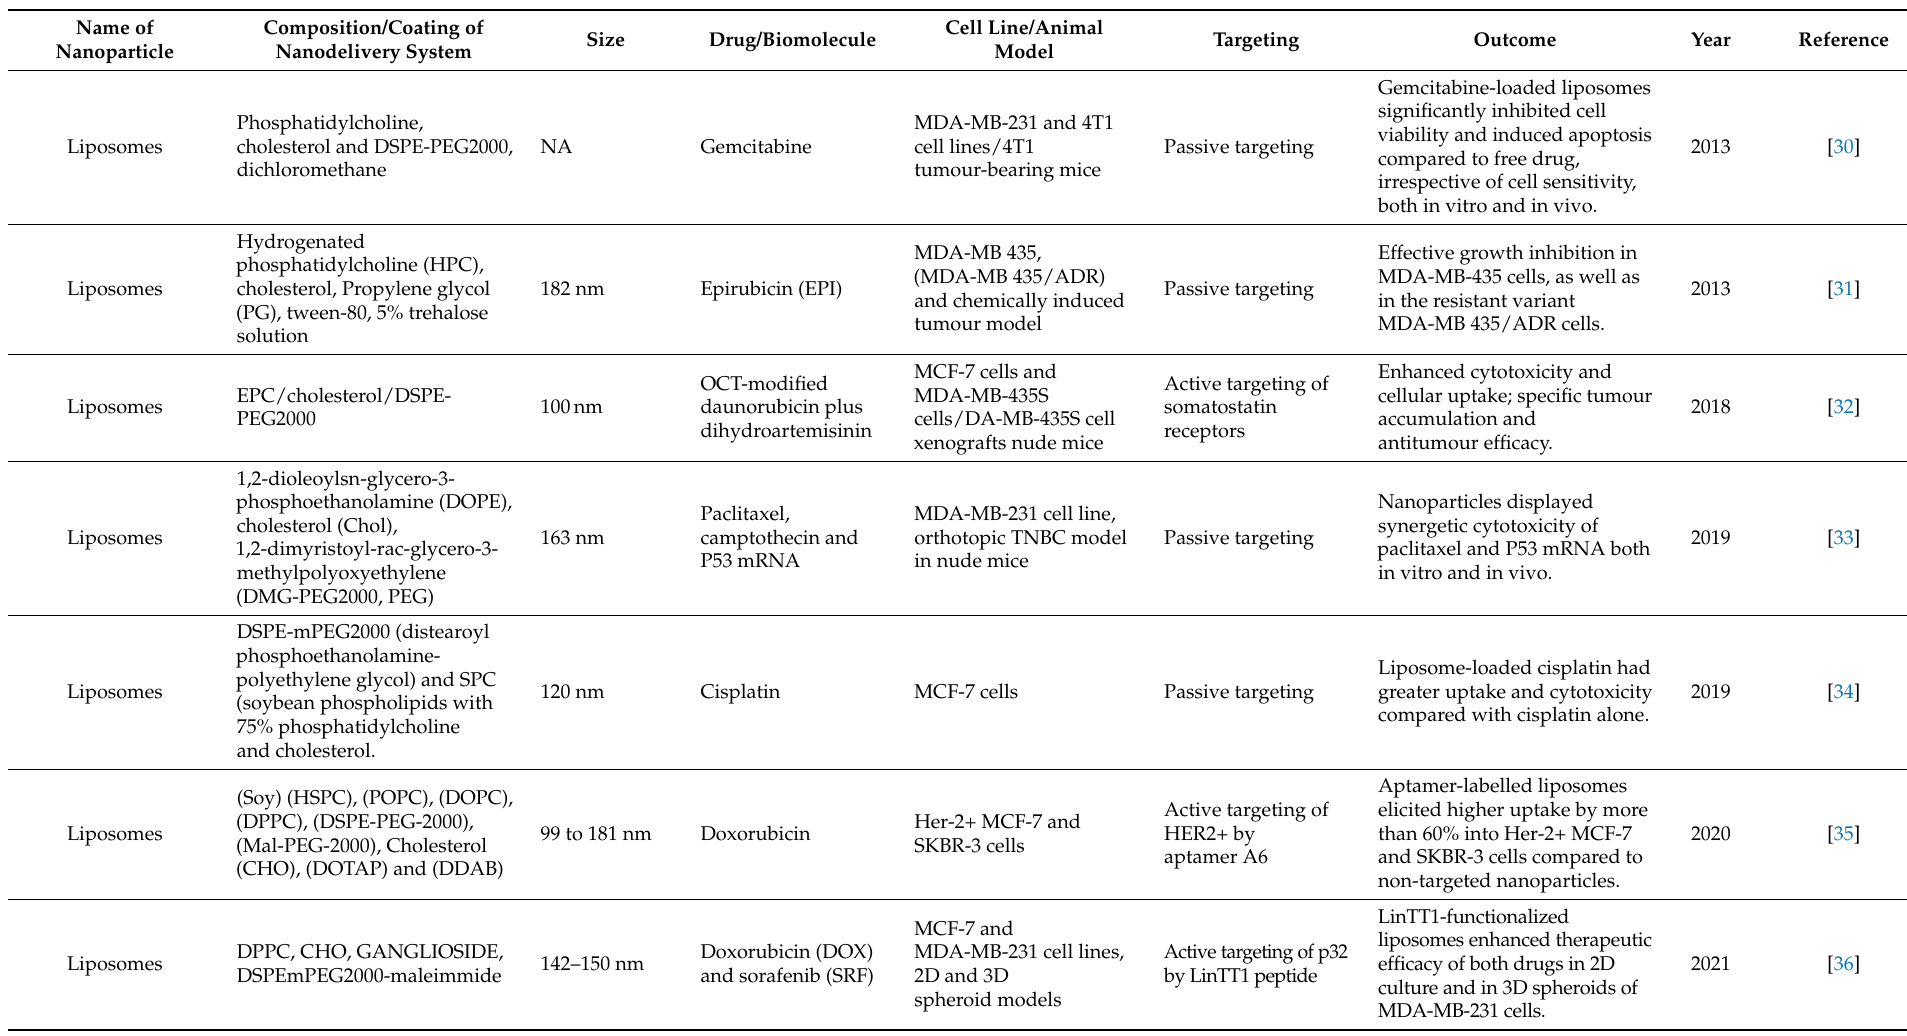
Table 1. Lipid-based nanoparticles investigated in breast